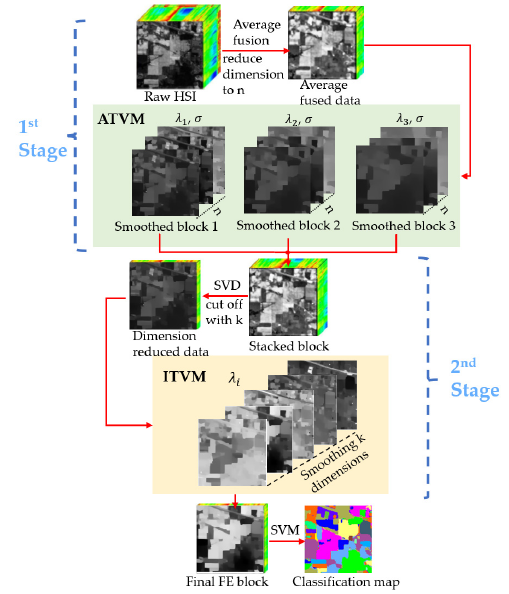
Figure 1. Flowchart of the proposed two-staged FE